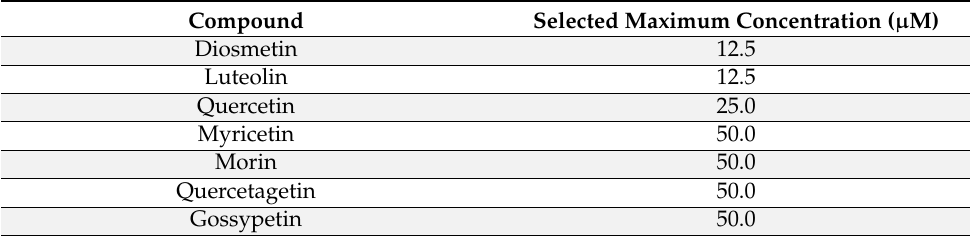
Table 1. Maximum non-cytotoxic flavonoid concentrations in Caco-2 cells, as determined by MTT assay. Compound Selected Maximum Concentration ( µ